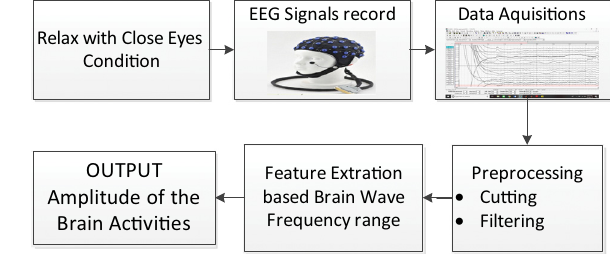
Figure 3: Experiment and